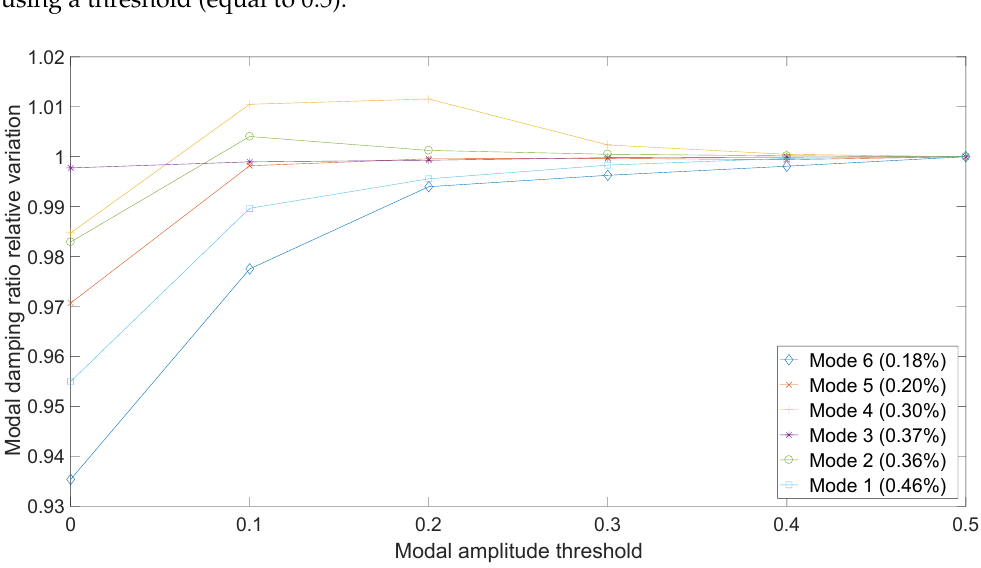
Figure 12. Relative variation of the modal damping ratios of the clamped–clamped beam as a function of the modal amplitude threshold of the normalized mode shapes used to select the points to calculate the averages of the modal damping